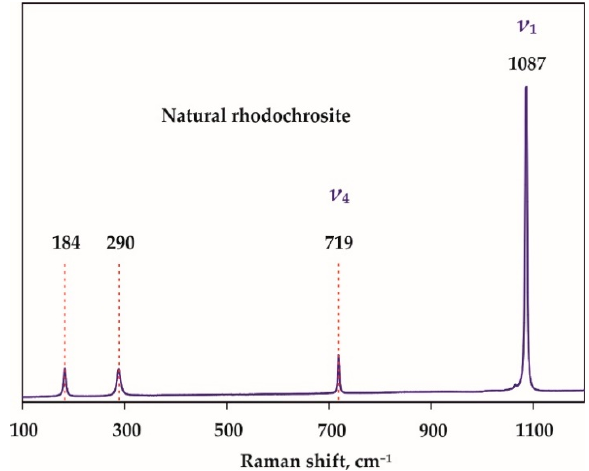
Figure 2. Raman spectrum of natural rhodochrosite Mn 0.97 Fe 0.02 Mg 0.01 Ca 0.01 CO 3 (China, Guangxi Zhuang Autonomous Region, Wuzhou Prefecture, Cangwu Co., Wutong Mine (Wudong Mine)). υ 1 , υ 4 —the high-frequency vibrational modes representing internal modes of the CO 32 − group.